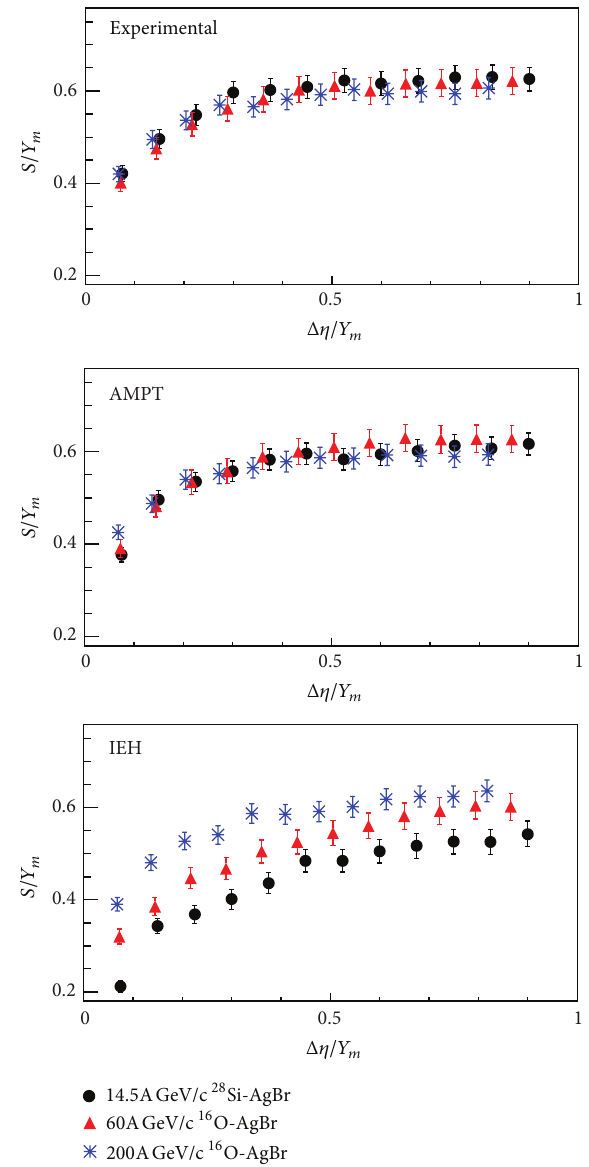
Figure 2: Dependence of 𝑆/𝑌 𝑚 on Δ𝜂/𝑌 𝑚 for the real, AMPT, and IEH event samples at the three incident